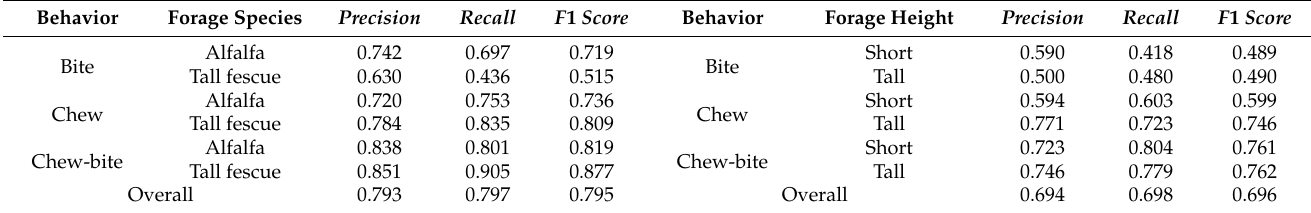
Table 4. Precision , recall , and F 1 score for classifying the ingestive behaviors under various forage conditions.